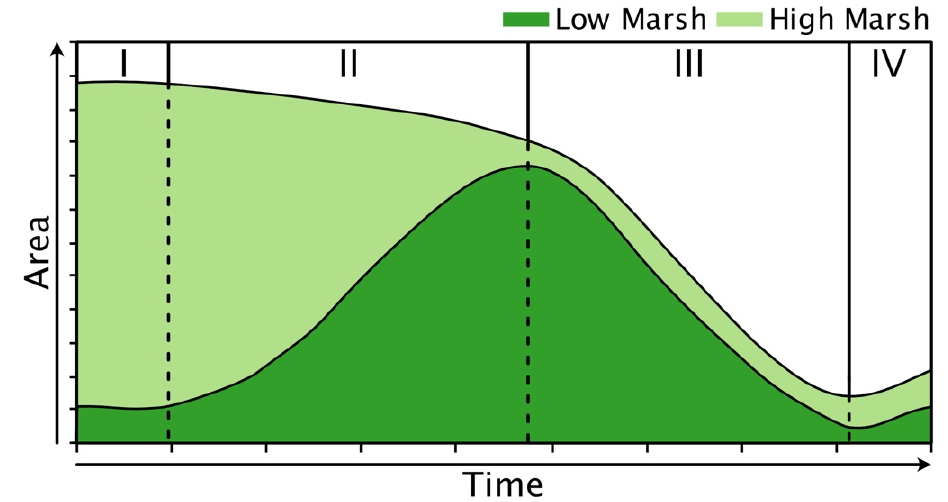
Figure 11. Schematic representation of the four identified phases associated with salt marsh area evolution in an SLR context. ( I ) Stability; ( II ) loss of maturity; ( III ) loss of area; ( IV ) recovery.